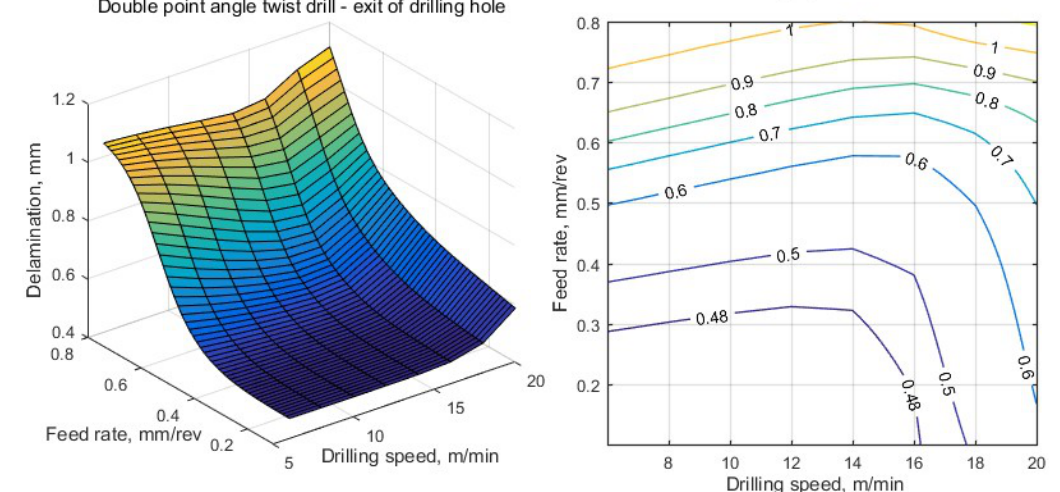
Figure 7. ANN-fitted delamination response functions at the entry ( top ) and exit ( bottom ) of a hole drilled with double-point angle drill is presented as 3D surfaces ( left ) and contour plots ( right ).